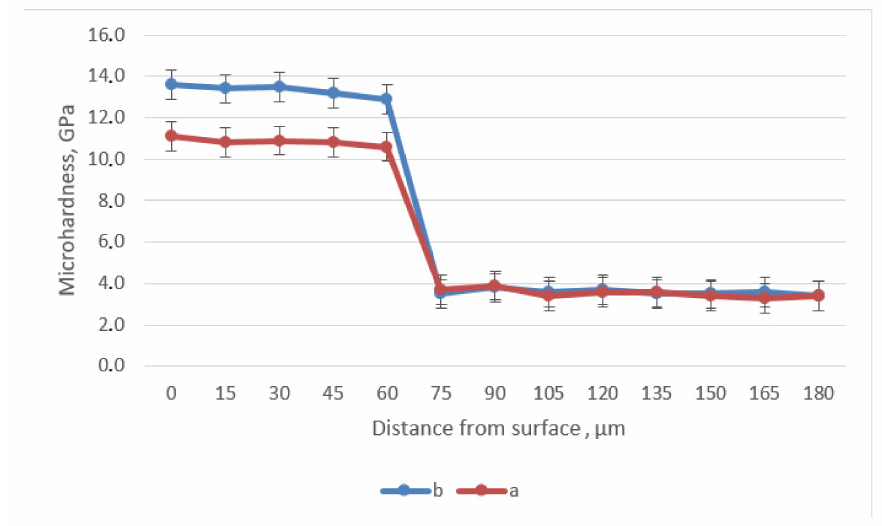
Figure 6. Distribution of hardness graph by depth of A90-P0 ( a ) and A80-P10 ( b )